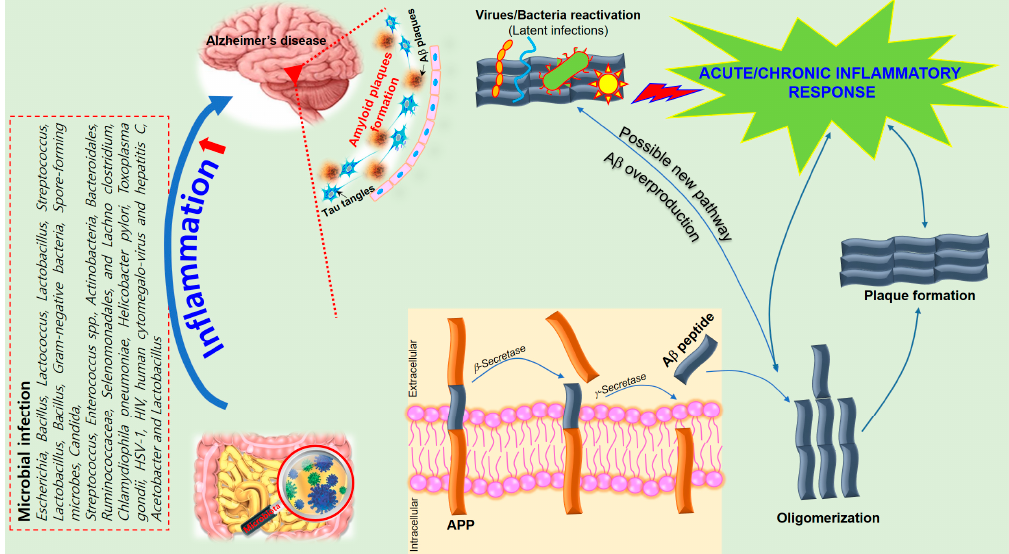
Figure 2. A schematic of the hypothetical chain of events via which brain infection may lead to pathological amyloid- β peptide (A β ) plaque formation in the brain. The amyloid precursor protein (APP) is processed by secretases into different peptides, including A β . The gut microbiota plays a significant role in the development of Alzheimer’s disease (AD) since A β functions as an antimicrobial peptide via oligomerization and plaque formation, trapping invading microorganisms, including bacteria, fungi, viruses, and protist parasites (detailed in Table 2). A β plaque formation in response to infection could result in a neuroinflammatory effect of microbiota on AD and neurodegeneration due to collateral damage in plaque-surrounding